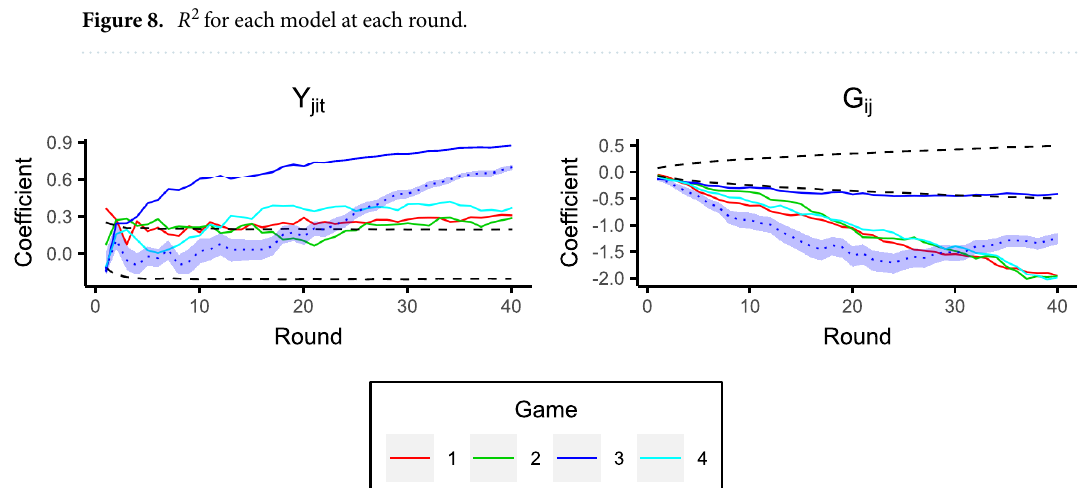
2 Figure 8. R for each model at each round.